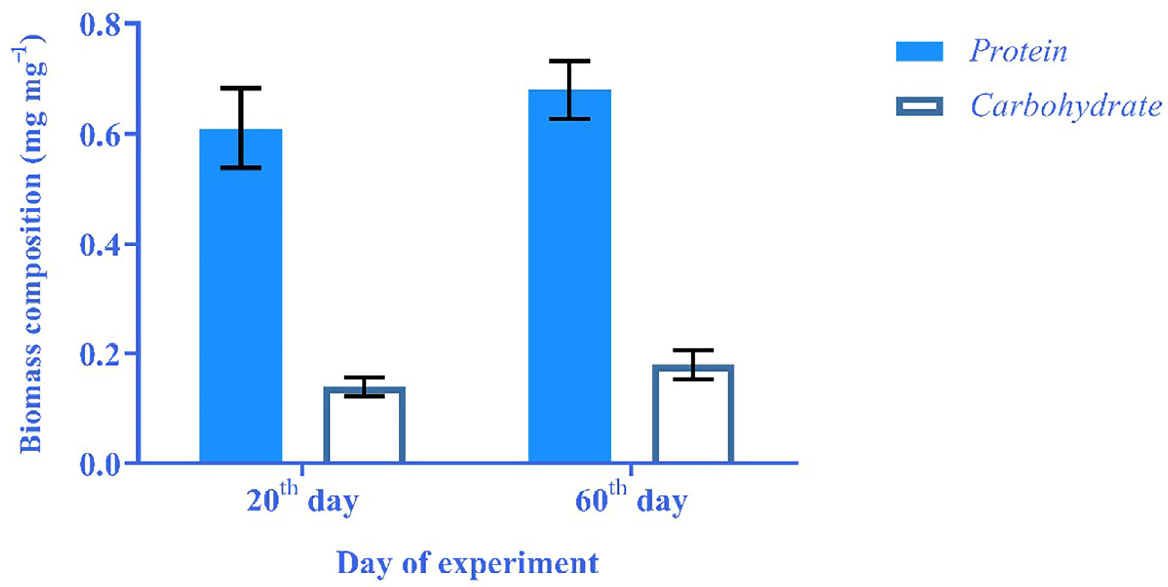
Figure 4. Comparison of protein and carbohydrate contents in 20th and 60th day of experiment.